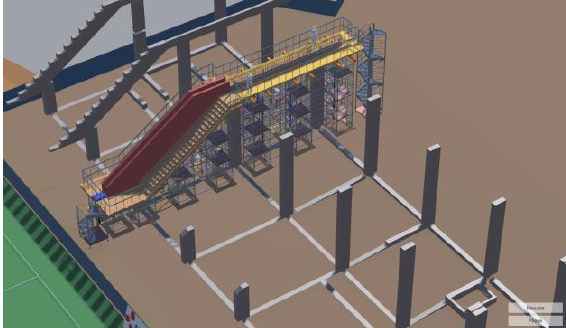
Fig. 4. An application made by Unity with VR simulated